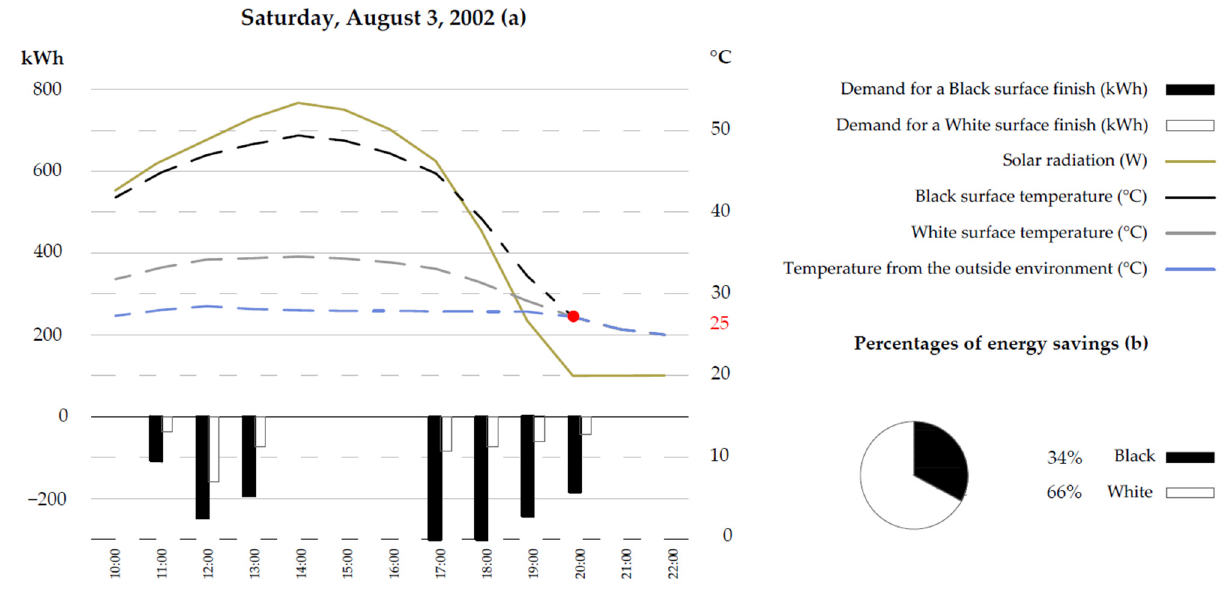
Figure 17. ( a ) Surface temperature and energy performance for 3 August 2002, in Barcelona. ( b ) White vs. black surface finish energy